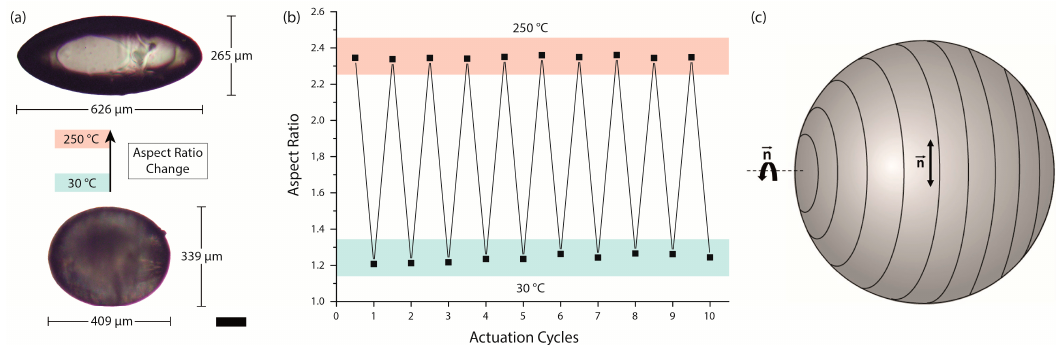
Figure 3. ( a ) Actuation of a single LCE particle before (30 °C, undercooled nematic state) and after (250 °C, isotropic state) the thermal-initiated phase transition. The aspect ratio of the particle is almost doubled during the actuation process; ( b ) Aspect ratio of the particle at 10 sequent actuation cycles, which demonstrates the overall reversibility of the LCE’s shape change; ( c ) Schematic drawing of the supposed concentric director field within the particle. The director is aligned parallel to the black lines (scale bar: 100 µm).